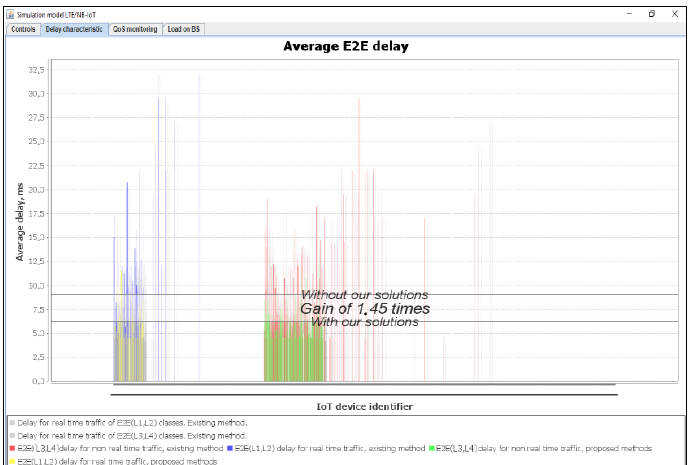
Figure 16. Average E2E delay gain for IoT services — our solution (average load of IoT controller ρ = 18%).